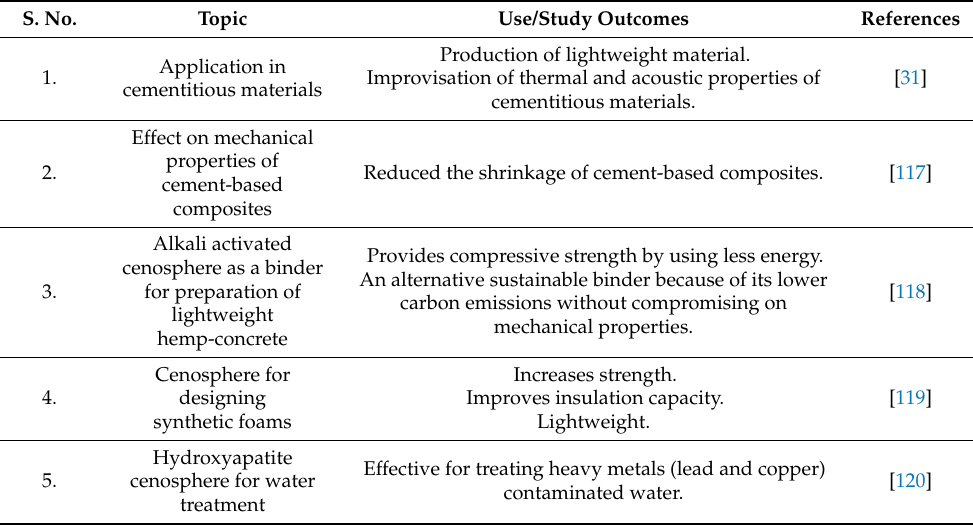
Table 2. Research that carried out in different fields incorporating